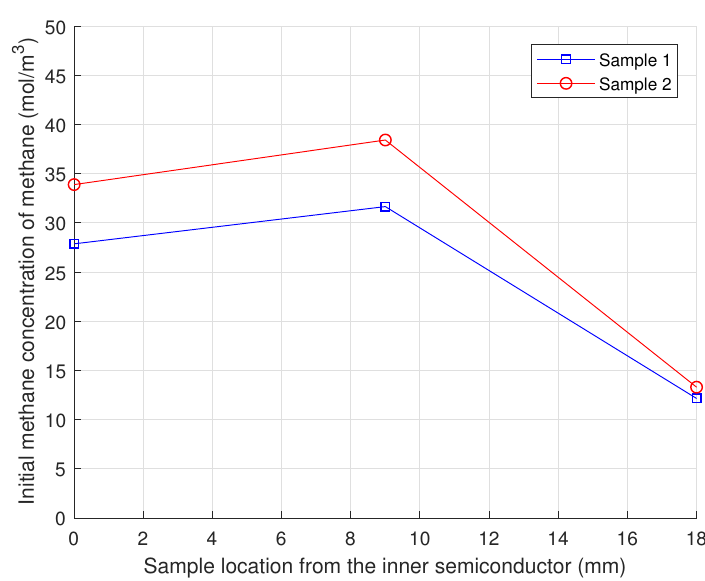
Figure 8. Nonuniform methane concentration datasets for a new XLPE insulated cable measured by Smedberg et al.